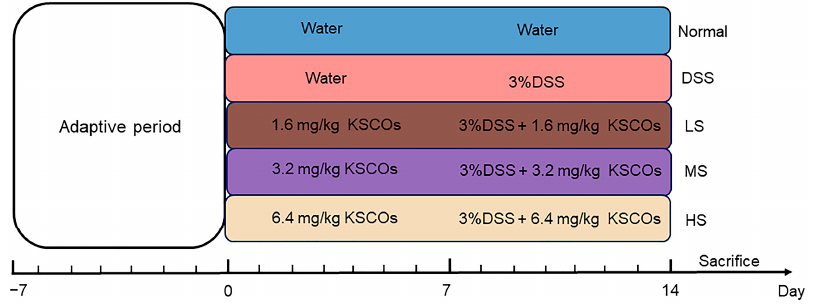
Figure 9. The schematic of experimental procedure.